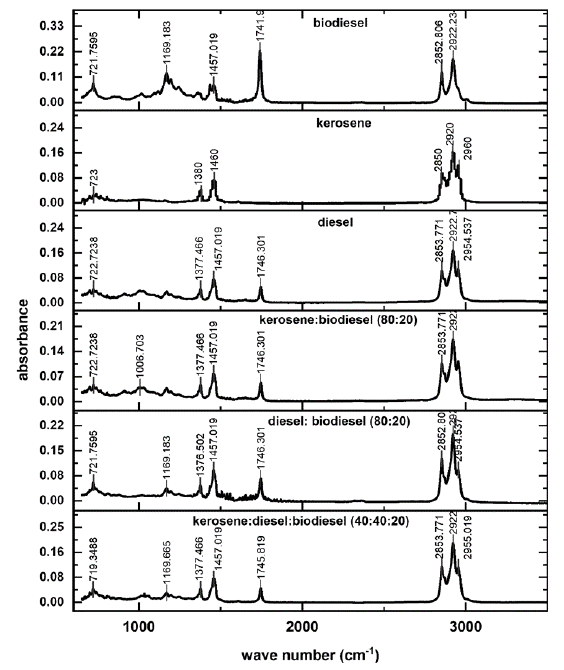
Fig. 5. ATR-FTIR absorption spectra of biodiesel, kerosene, diesel, kerosene: biodiesel (80:20) blend, diesel: biodiesel (80:20) blend and kerosene: diesel: biodiesel (40:40:20) blend in the range of 600 cm − 1 -3500 cm − 1